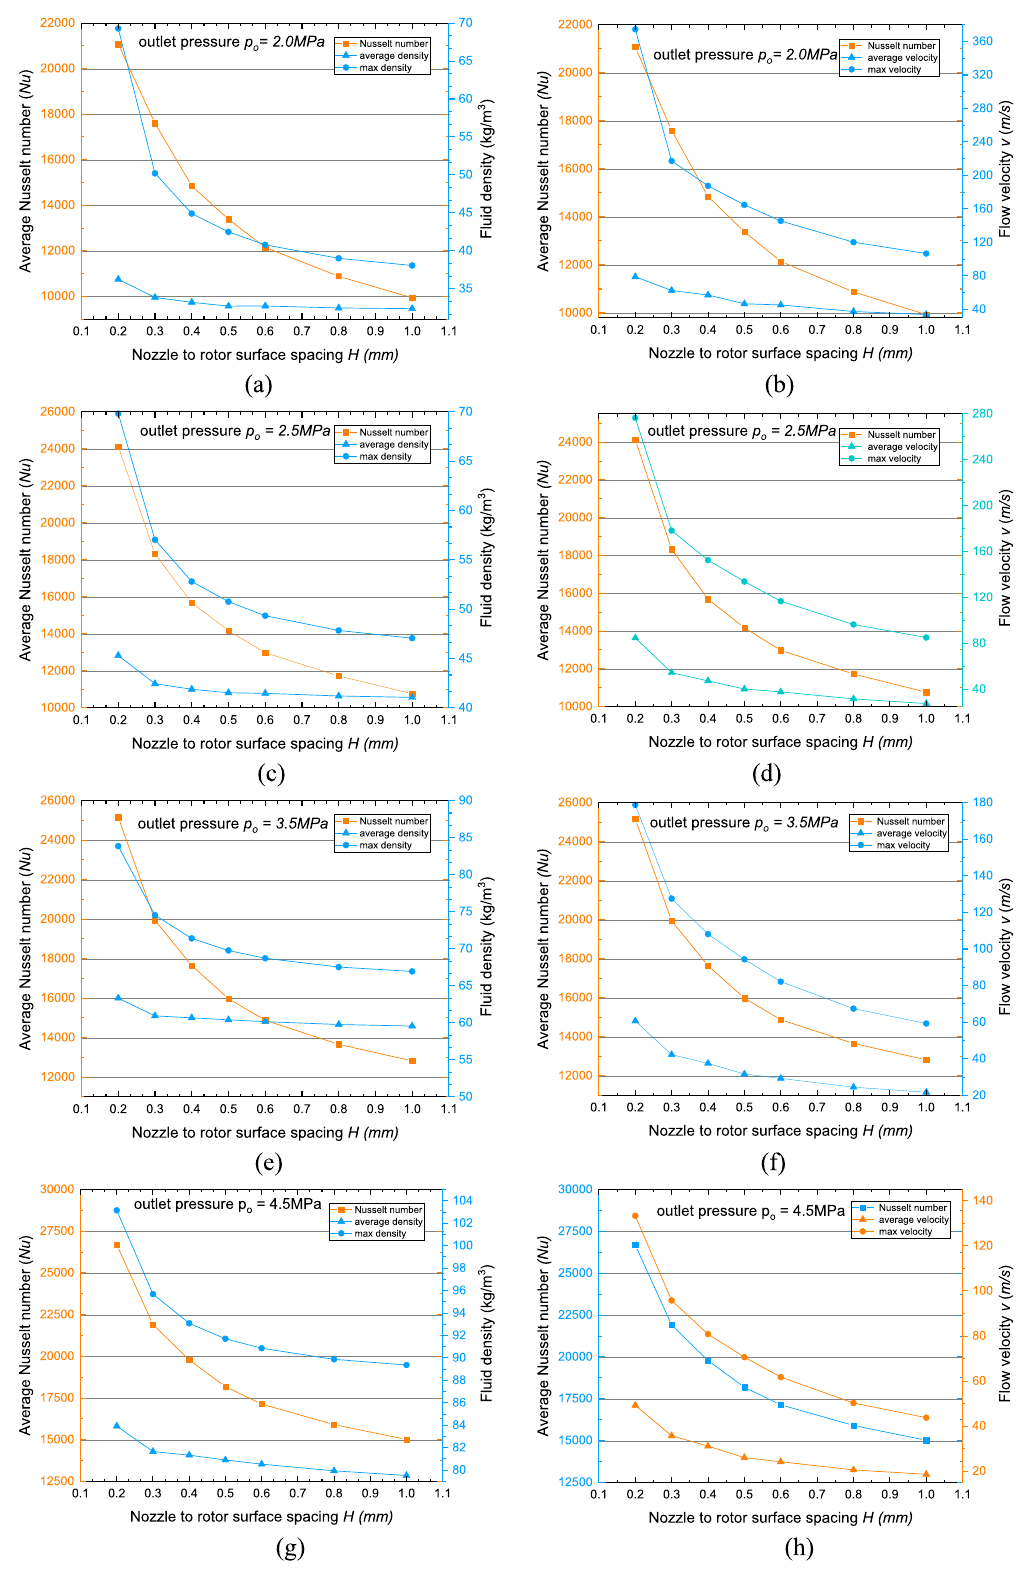
Fig. 11. Comparison of the average Nusselt number variation trend with that of fl uid density and velocity, d i =3 mm , q = 0.051kg/s. (a) Nu vs fl ow density, p o =2.0 MPa , (b) Nu vs fl ow velocity, p o =2.0 MPa , (c) Nu vs fl ow density, p o = 2.5 MPa , (d) Nu vs fl ow velocity, p o =2.5 MPa , (e) Nu vs fl ow density, p o =3.5 MPa , (f) Nu vs fl ow velocity, p o = 3.5 MPa , (g) Nu vs fl ow density, p o =4.5 MPa , (h) Nu vs fl ow velocity, p o = 4.5 MPa